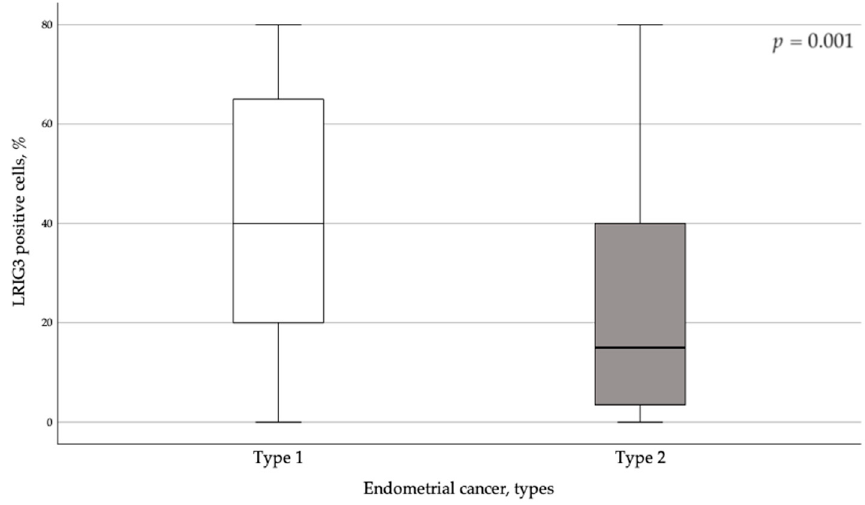
Figure 1. Correlation between progesterone and estrogen receptors expression, and relapse and death. Figure 2. LRIG3 positive cells (%) in different endometrial cancer tumor types. Table 2. Immunohistochemical staining for LRIG1, LRIG2, and LRIG3 ( n = 75).